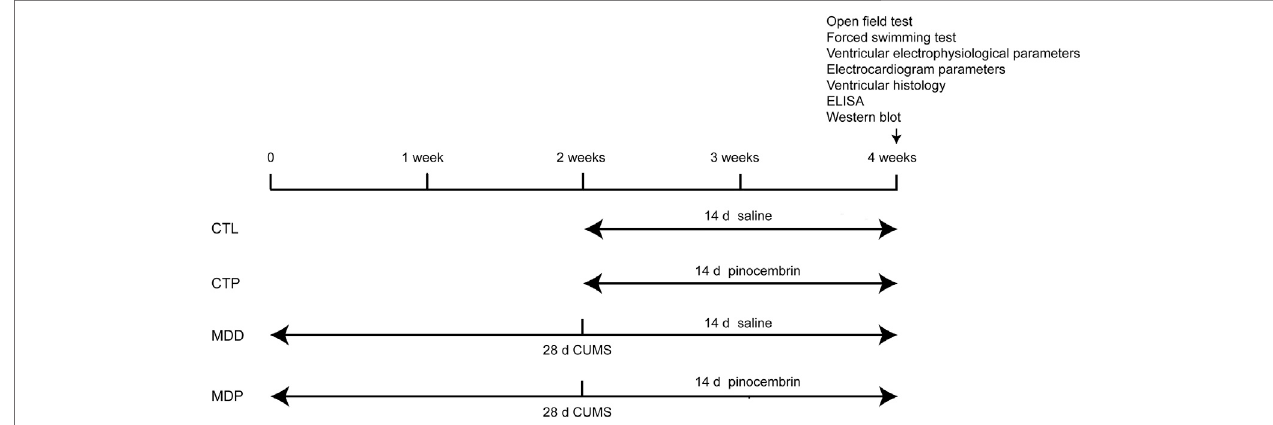
FIGURE 1 | Time axis of procedures used in the present study. CUMS, chronic unpredictable mild